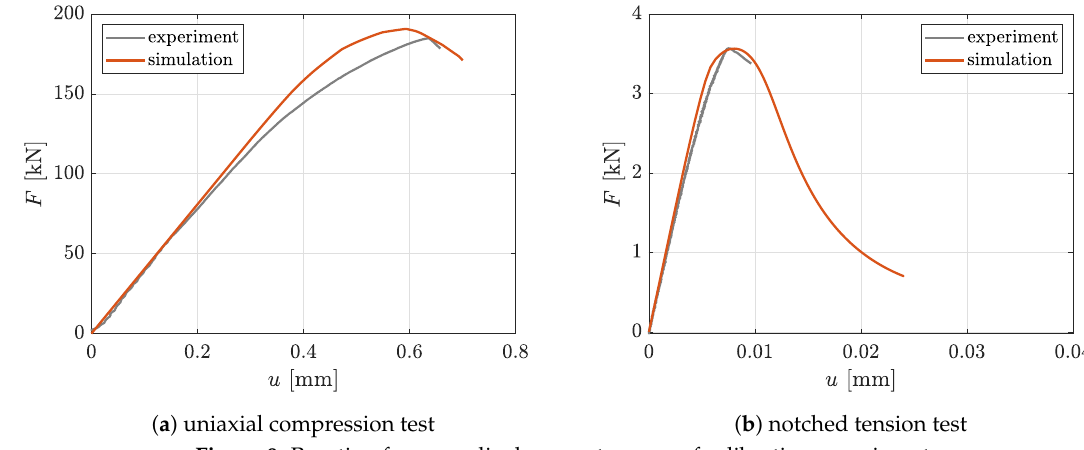
Figure 9. Reaction force vs. displacement curves of calibration experiments.